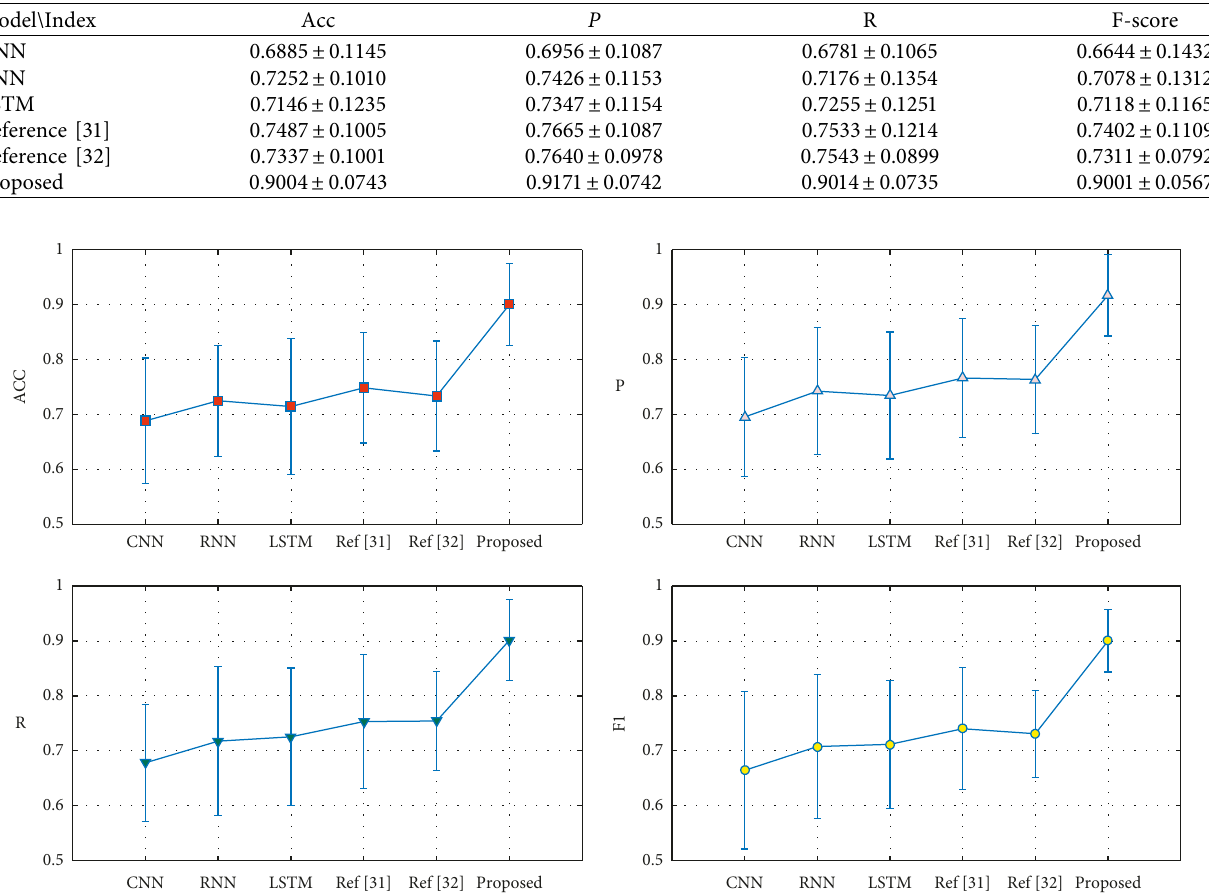
Figure 9: Experimental results of each model on different indexes in 5-classification